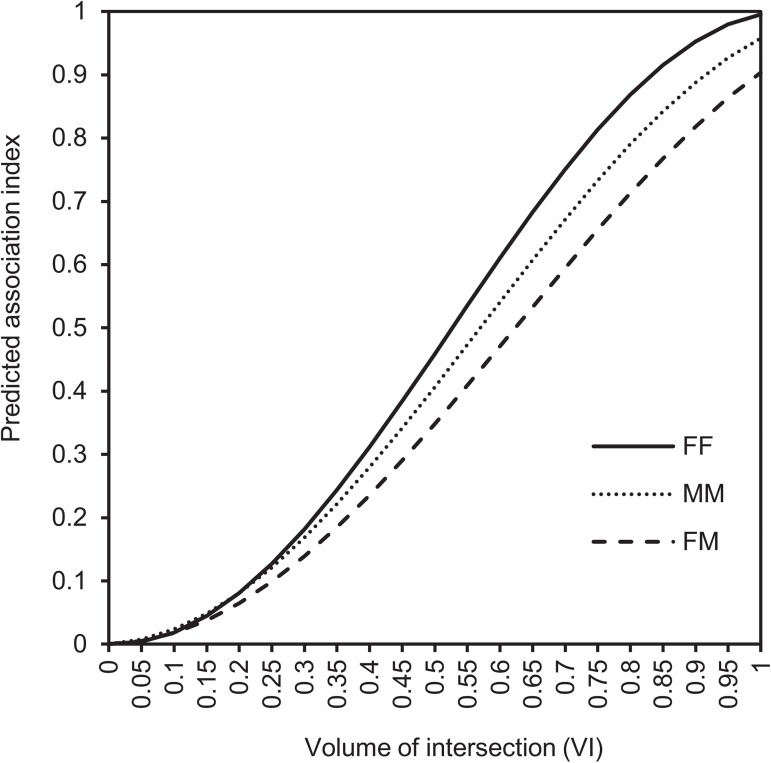
Predicted pairwise spatial association indices by sex class at different levels of volume of intersection (VI) among adult mule deer.FF are pairs of females, MM are pairs of males, and FM are female-male pairs. No confidence intervals (CI) are shown to facilitate graph readability. For CI and observed values, see S3 Fig.